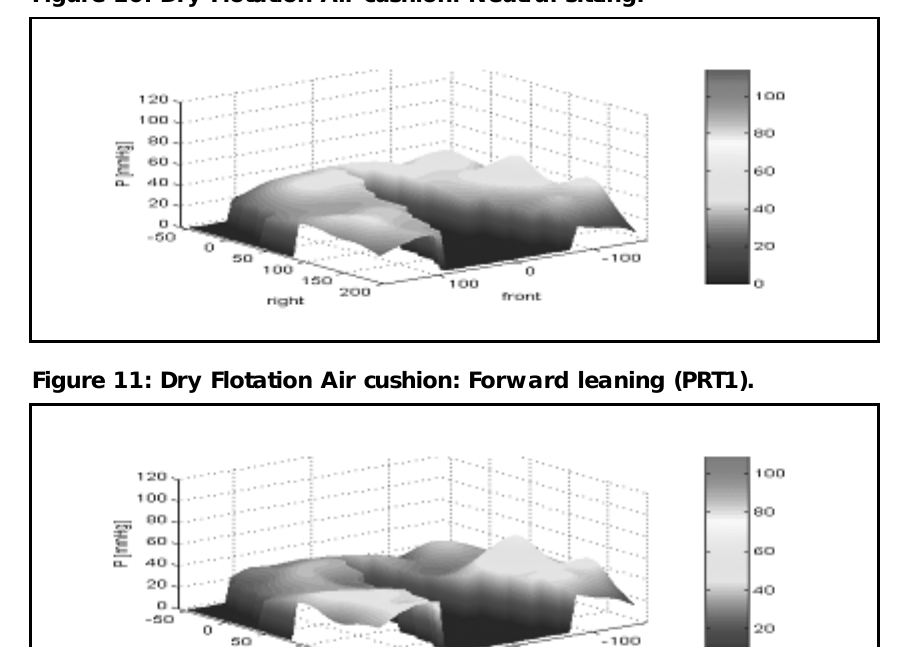
Figure 10: Dry Flotation Air cushion: Neutral sitting.